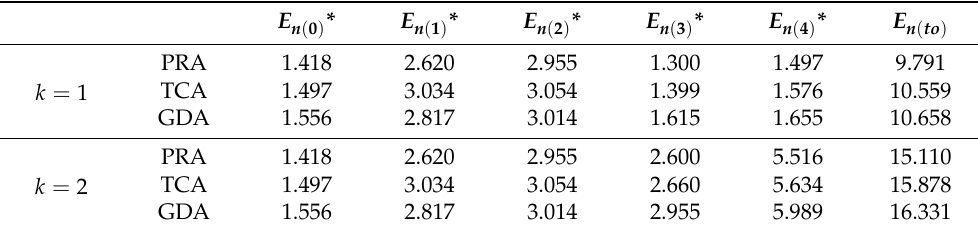
Table 6. Comparison of the emission volume of the three algorithms under the different cluster conditions (unit: